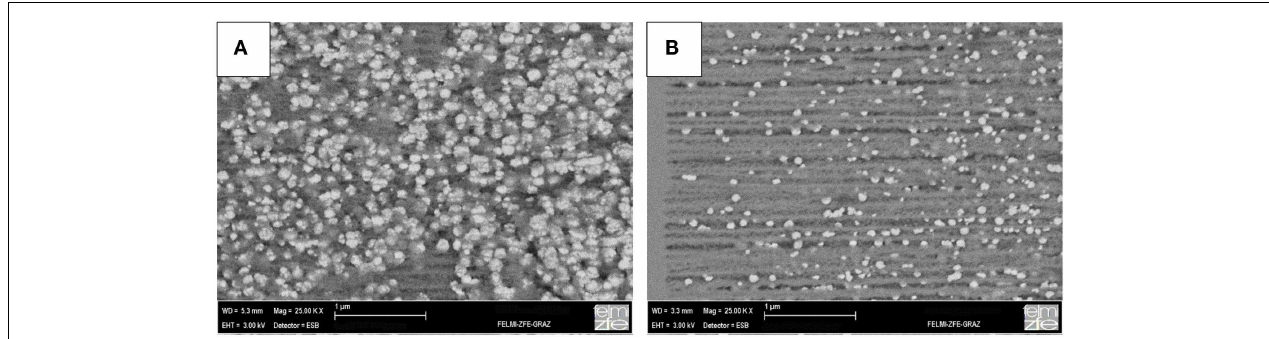
FIGURE 4 | (A) High filling fraction of Ni-particles within porous silicon and (B) low filling density of Ni-particles within the pores.The average particle size is 60nm.